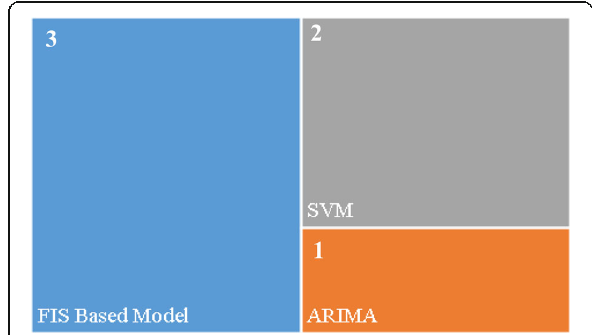
Fig. 8 Number of investigations for the different types of models, other than ANN-based, for SST